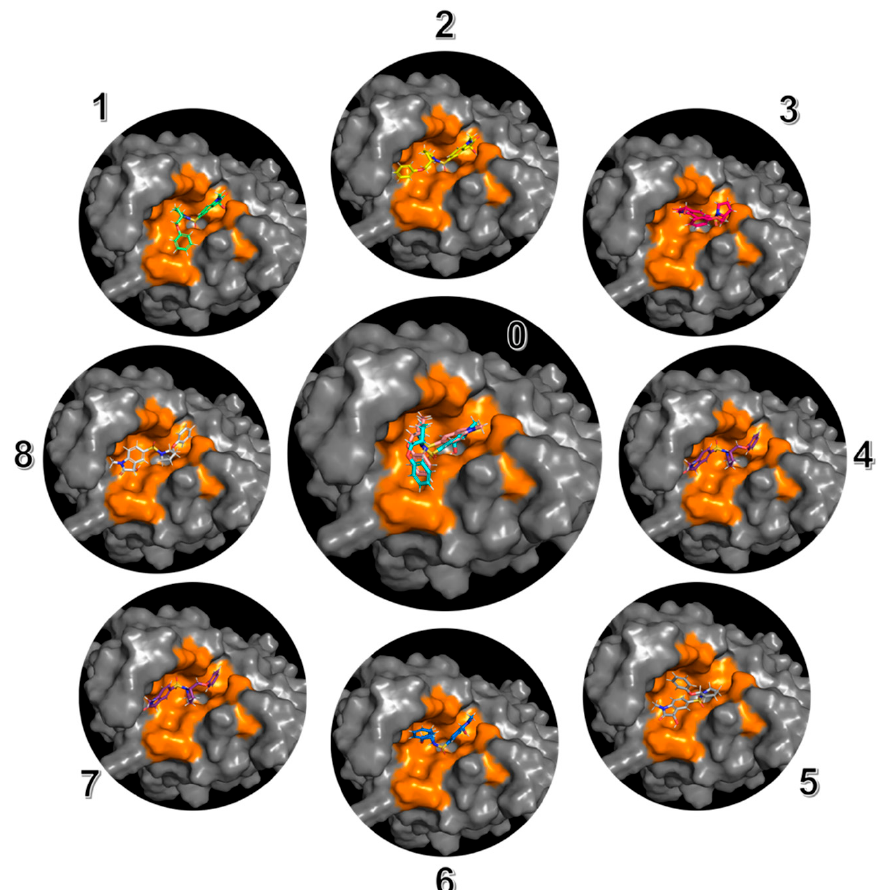
Figure 4. Energy distribution of the top 9 sampled ligand conformations ranked based on the conformational energy in the solution phase.